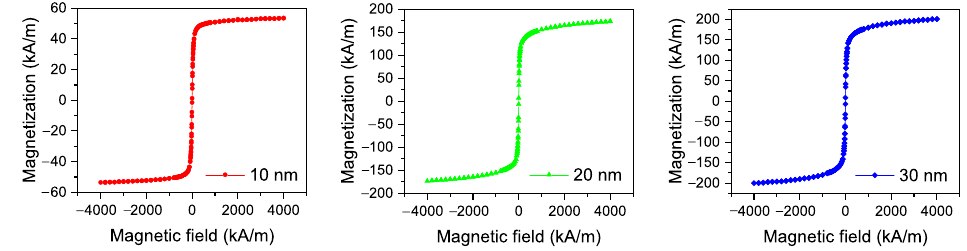
Figure 1. Magnetization curves of iron oxide nanoparticle powders measured at 295